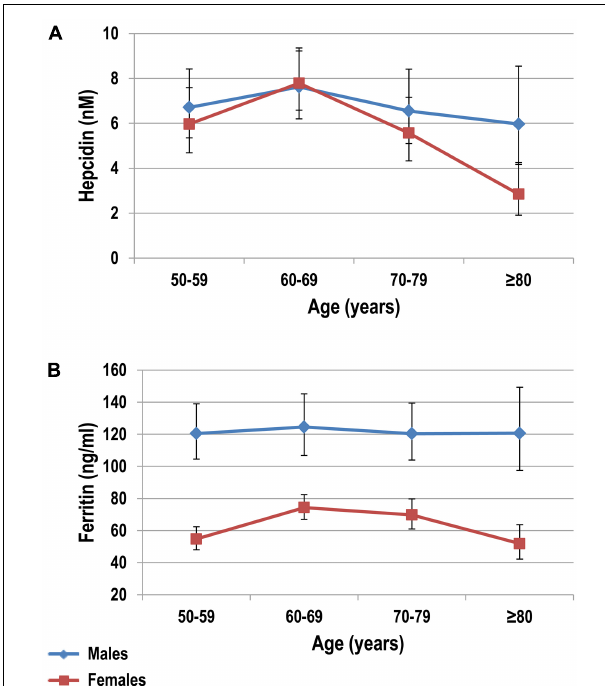
FIGURE 2 | Serum hepcidin (A) and ferritin (B) levels stratified by decades in healthy subjects older than 50 years. Subjects were from the Val Borbera study, a large population survey including 1657 subjects. Adapted fromTraglia etal.